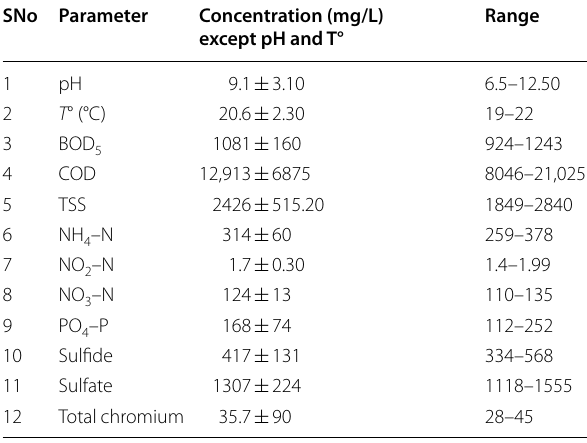
Table 2 Characteristics of Dire tannery wastewater SNo